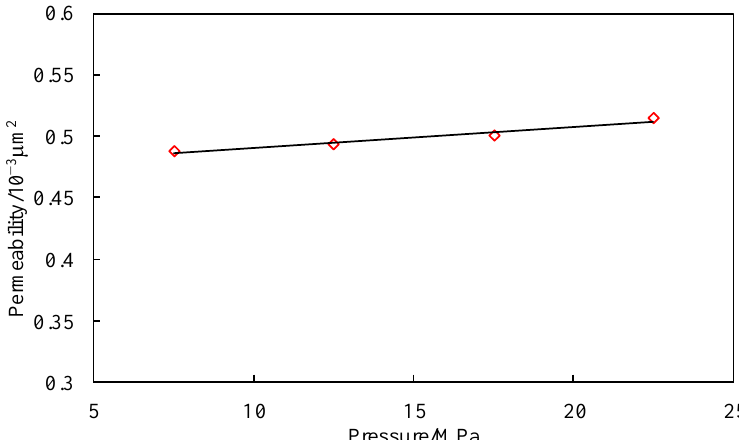
Figure A1. Experimental fitting results of salt dissolution.